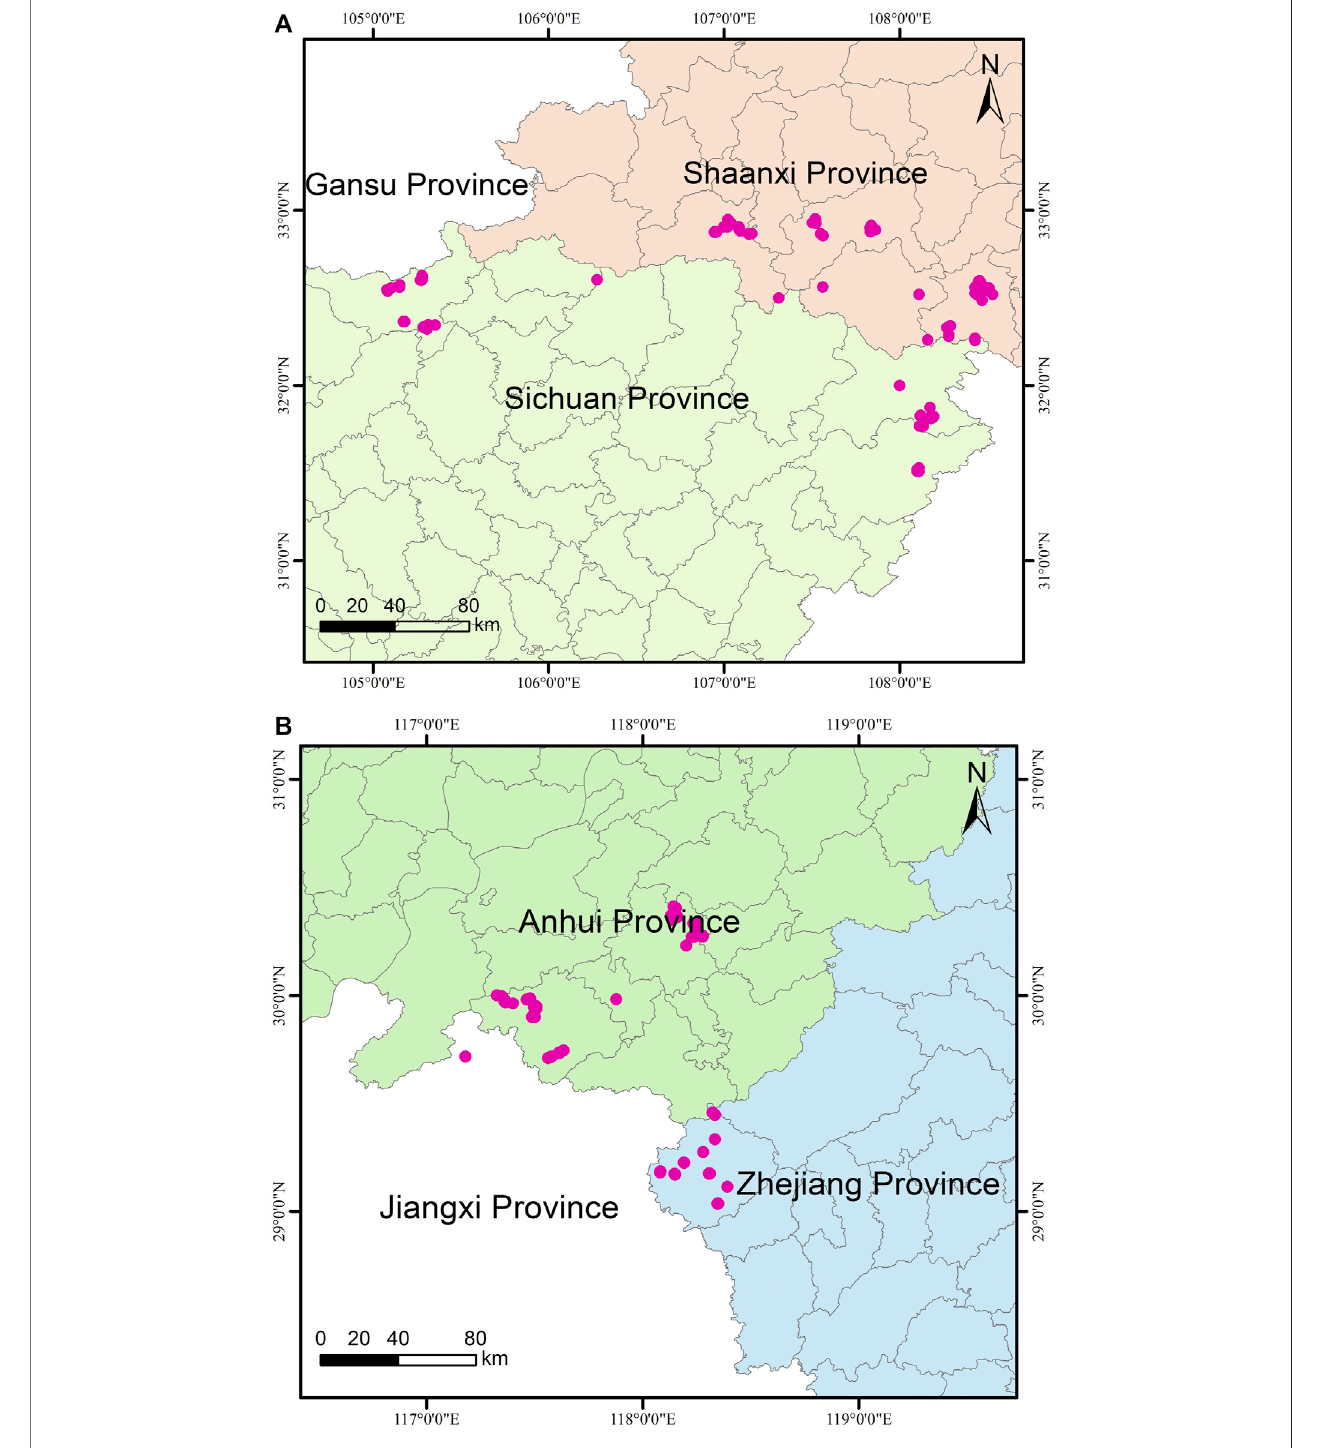
FIGURE 2 | A map of the data source area. (A) Qinba Mountain area; (B) Huangshan Mountain area.